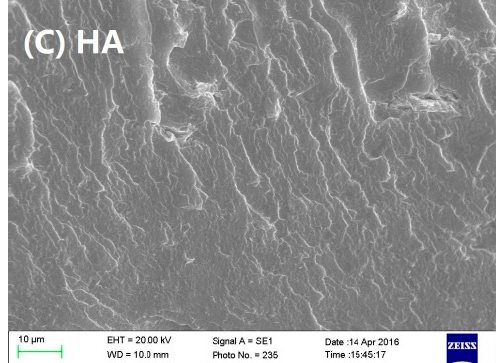
Figure 1. Morphology of the fractured surfaces of starch-based nanocomposites with ( a ) low-amylose content (LA), ( b ) middle-amylose content (MA) and ( c ) high-amylose content (HA).